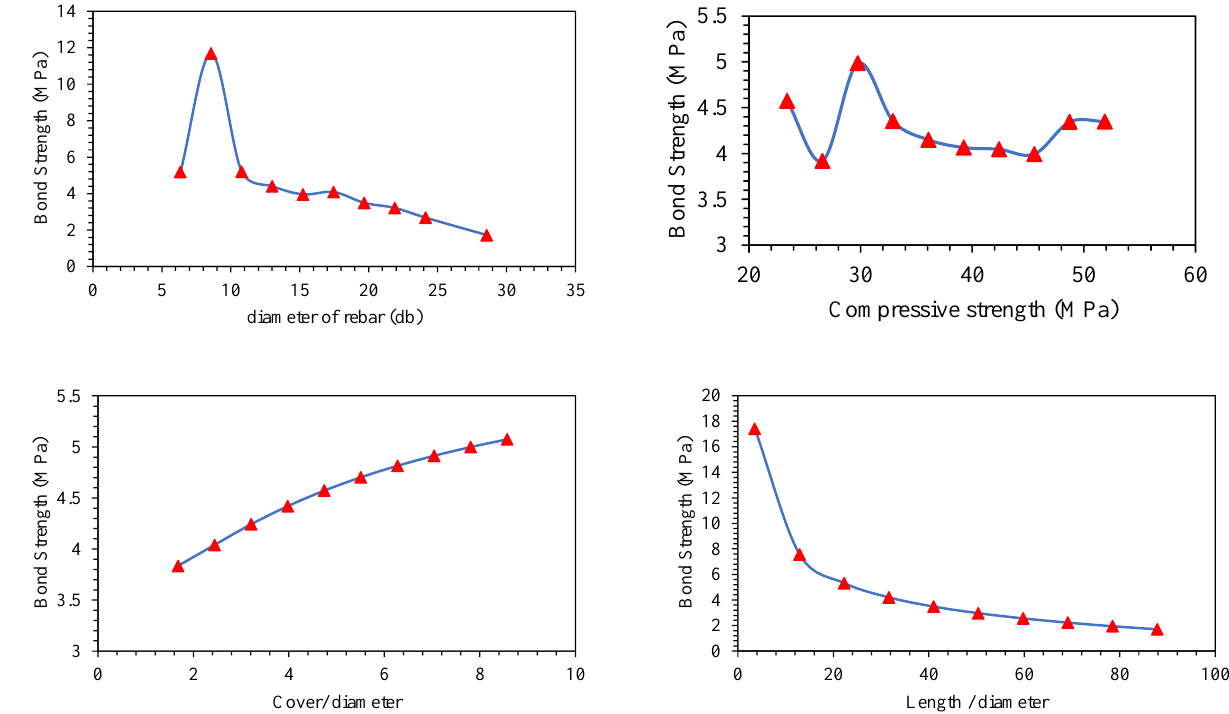
Figure 12. Effect of the contributing parameters on BS for B p type-I and B s type II.